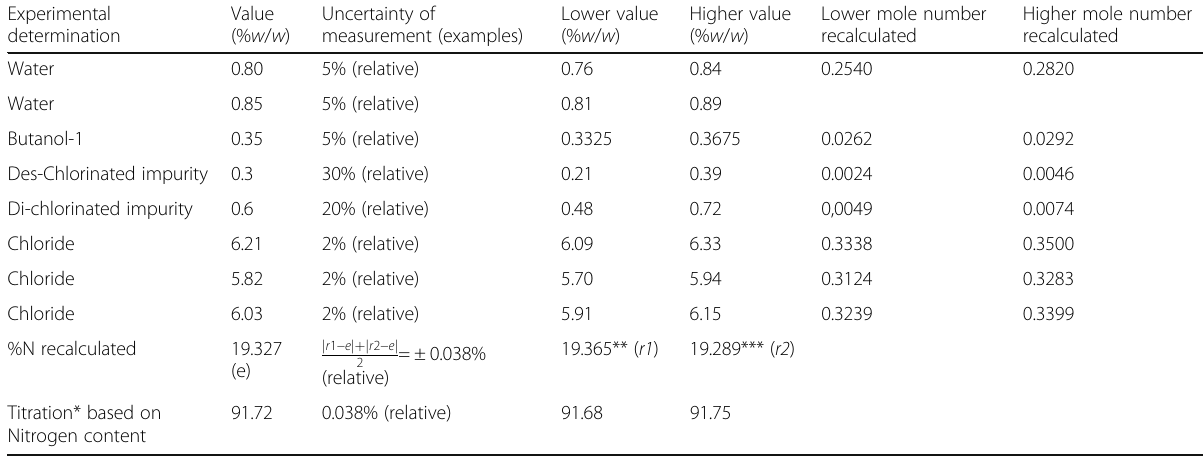
Table 4 Confidence interval of the titration value based on the nitrogen content, according to examples of uncertainty of measurements of each individual assay –– Mat-CHN recalculations